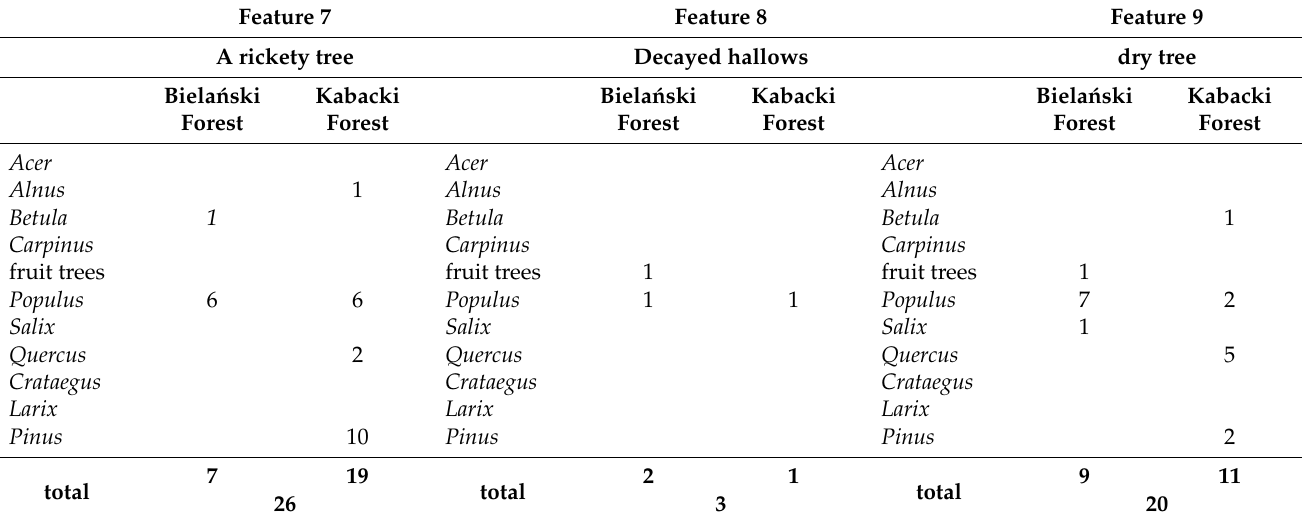
Table A2. Selected defoliated trees of poor health condition (features 7–12) in the Biela´nski Forest and the Kabacki Forest in Warsaw